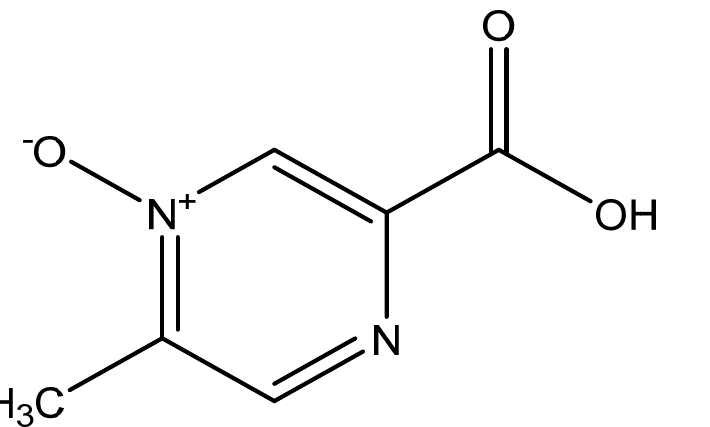
Figure 13. Structure of acipimox, a synthetic derivative of nicotinic acid used as a lipid lowering drug.